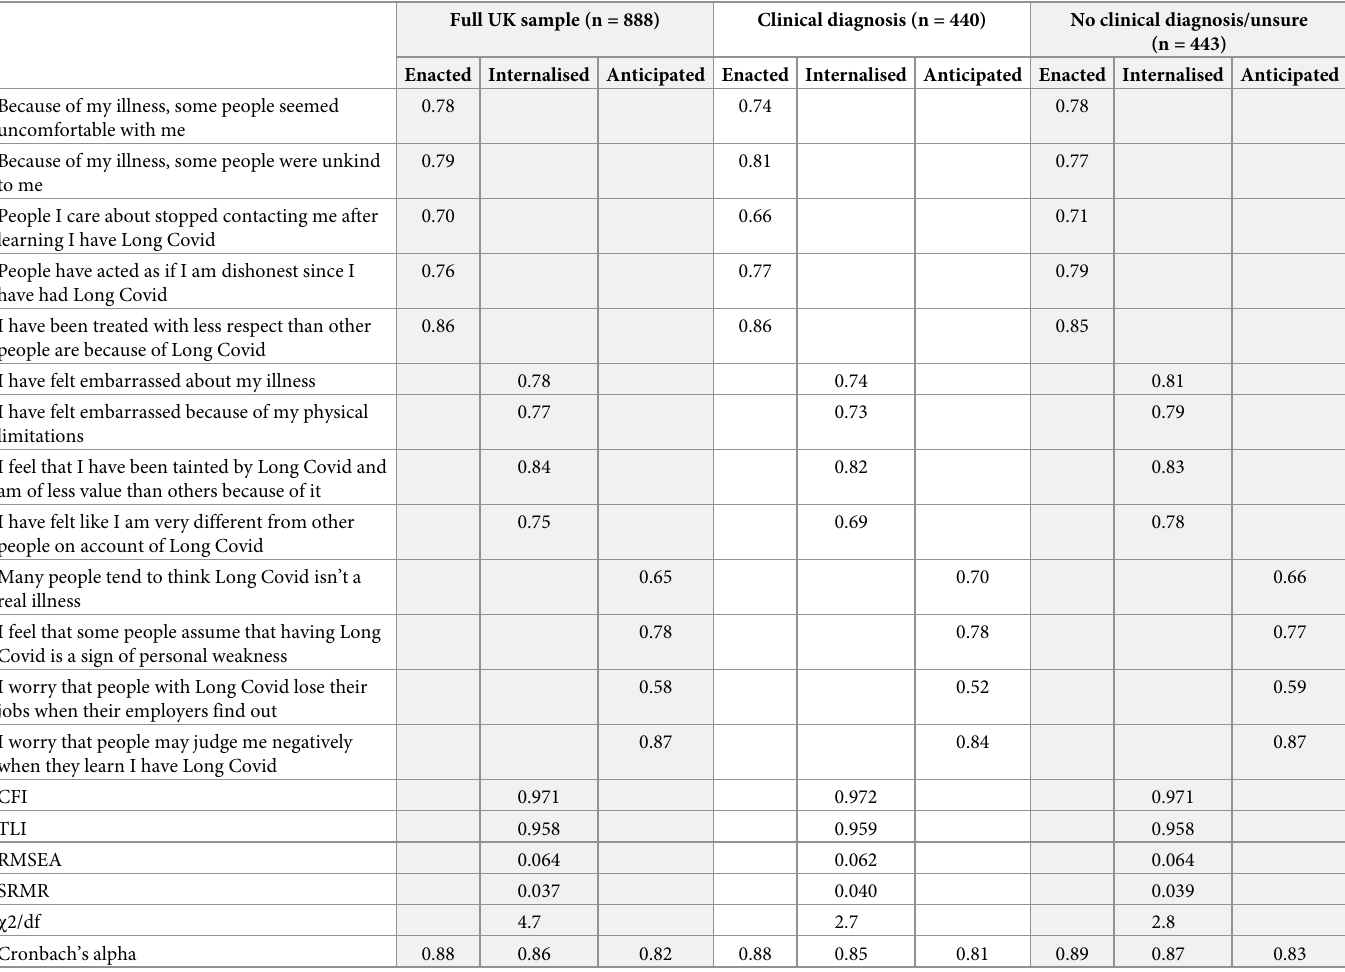
Table 3. Factor loadings of individual stigma items on subscales of internalised, enacted and anticipated stigma using confirmatory factor